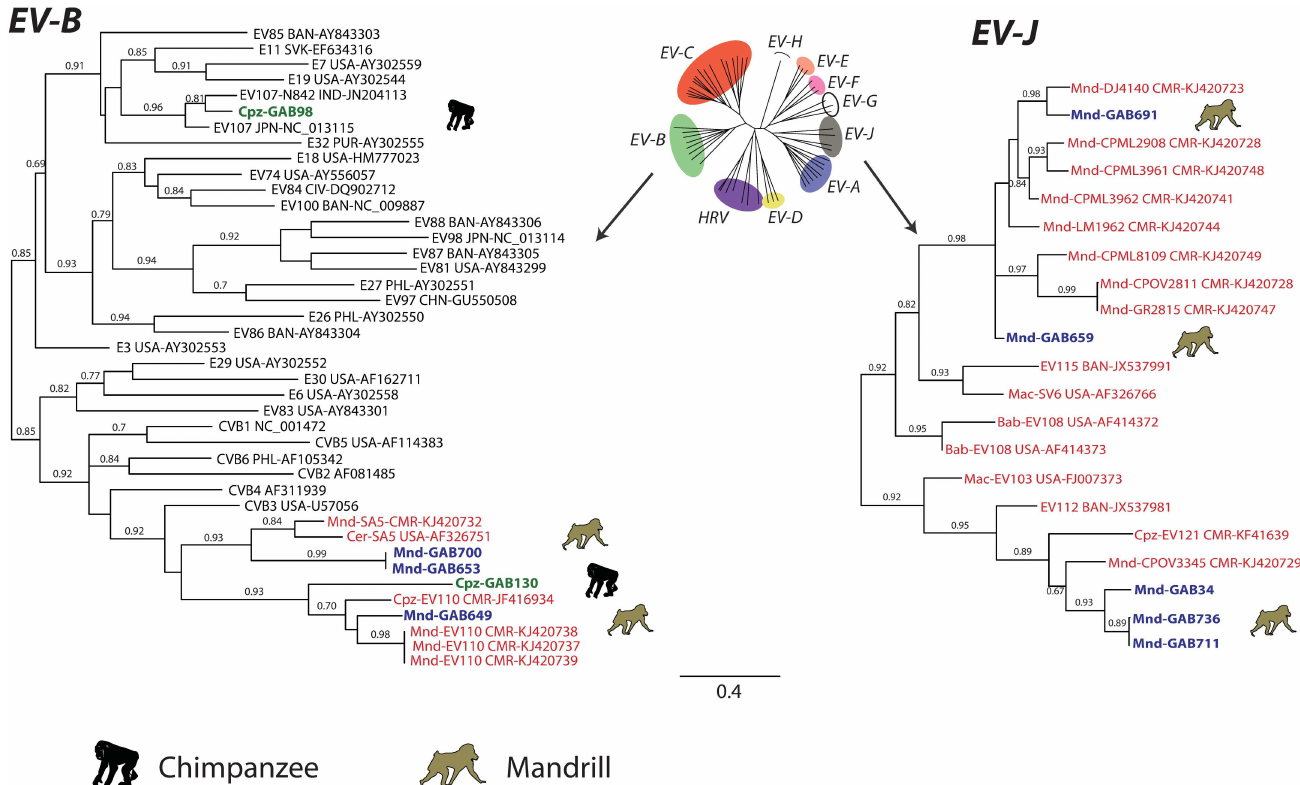
Fig 3. Phylogenetic relationship of EV strains based on approximately 320 nucleotides of the VP1 gene (positions 2,602 to 2,951 according to the poliovirus 1 genome, Genbank # V01149). Methods and designations are identicalto Fig